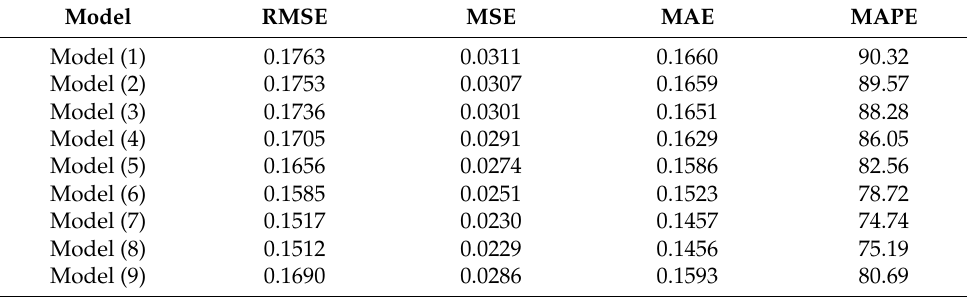
Table 3. Evaluation the level of uncertainty for triangular IT2 MF.